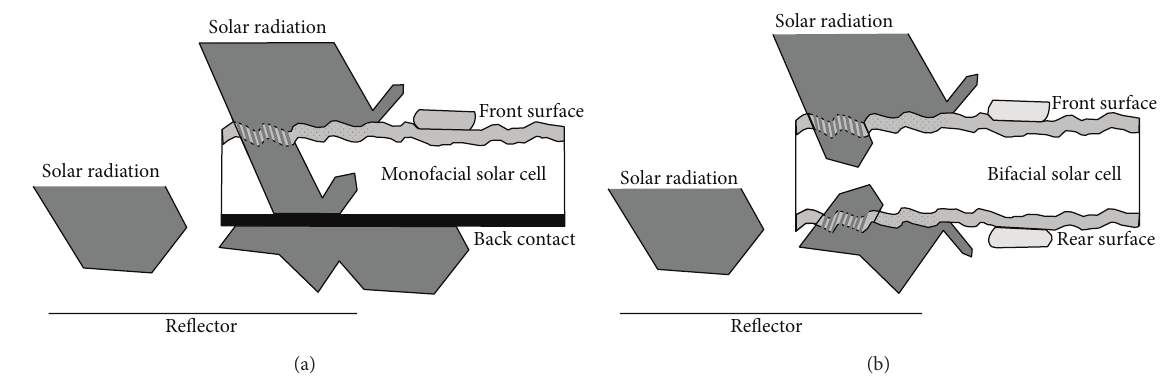
Figure 1: Radiation absorptions of monofacial and bifacial PV solar